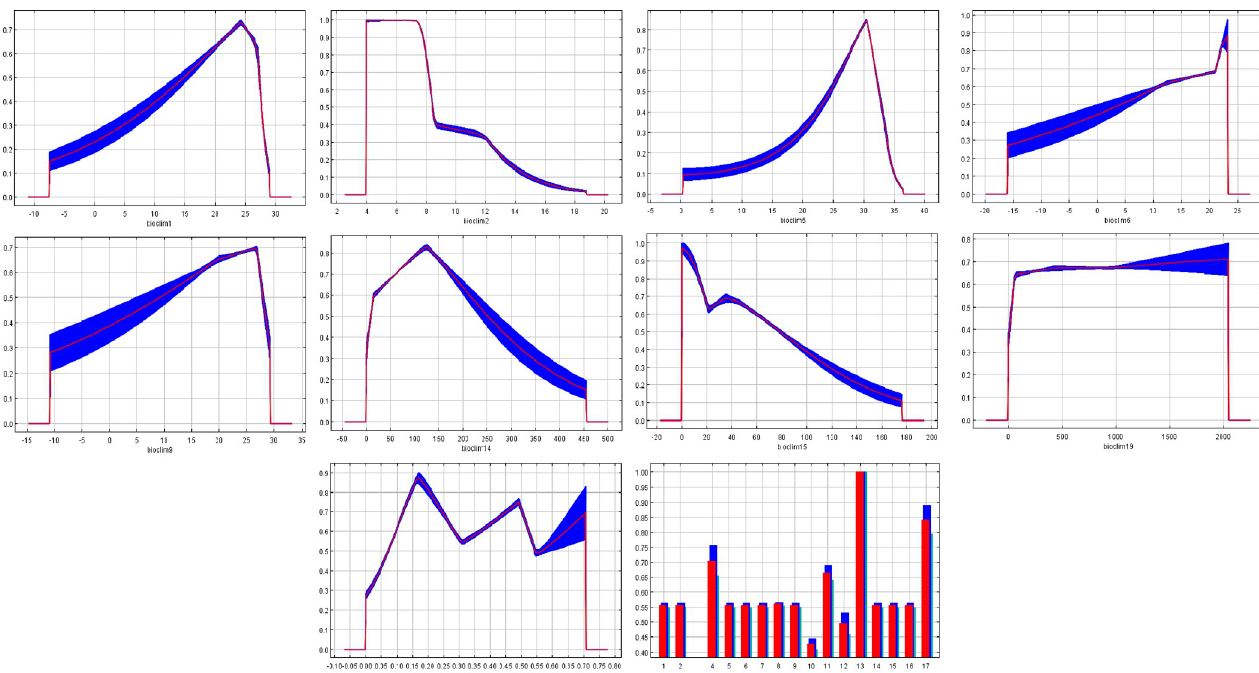
Fig 4. Response curves for the Hg . janthinomys model. Each curve represents a Maxent model created using only the corresponding variable. The red lines represent the mean response of 20 Maxent runs while blue represents the mean ± 1 standard deviation.